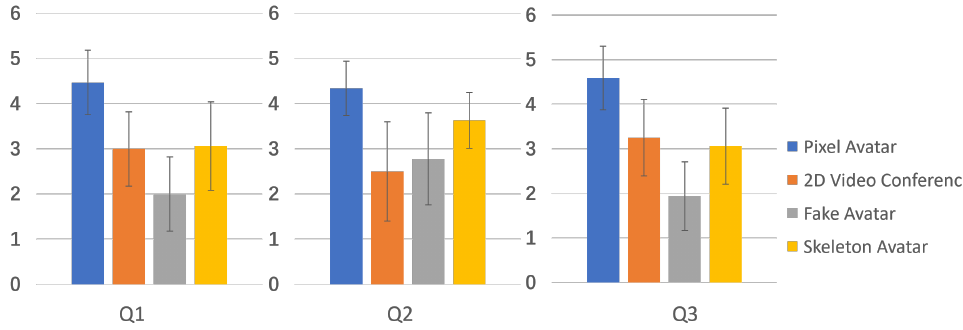
Figure 10. Results of the comparative experiments. The error bars in the chart represent standard deviations